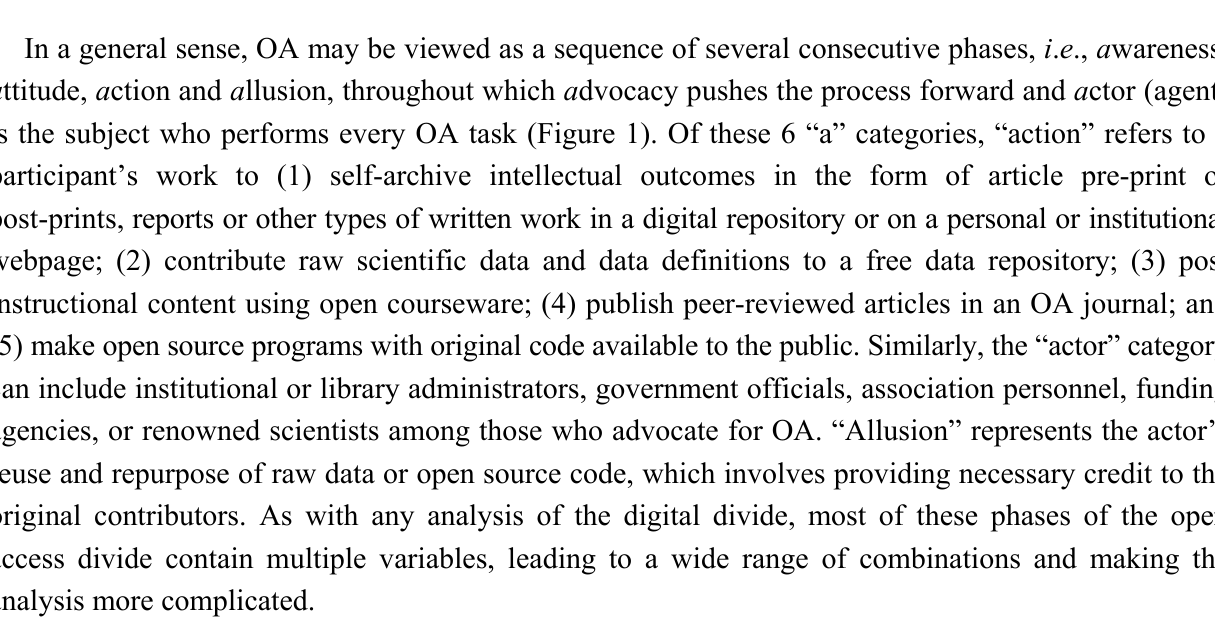
Figure 1. A conceptual relationship among various types of open access (OA)